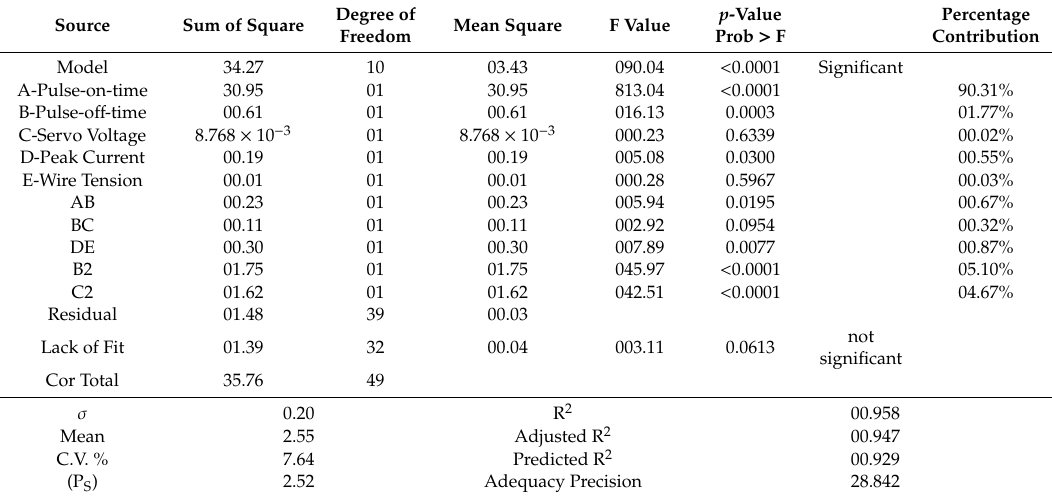
Table 6. Results of ANOVA analysis for the surface roughness (R a ).